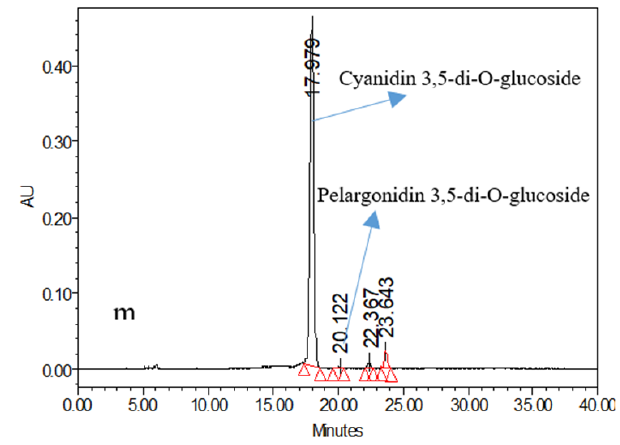
Figure 7. HPLC chromatograms of promising rose varieties. ( a ) Ashwini; ( b ) Pusa Arun; ( c ) Nehru Centenary; ( d ) Raktagandha; ( e ) Raktima; ( f ) Suryakiran; ( g ) Pusa Bahadur; ( h ) Bhim; ( i ) Dr. S.S. Bhatnagar; ( j ) Rose Sherbet; ( k ) Pusa Virangana; ( l ) Surkhab; ( m ) Pusa Ajay.